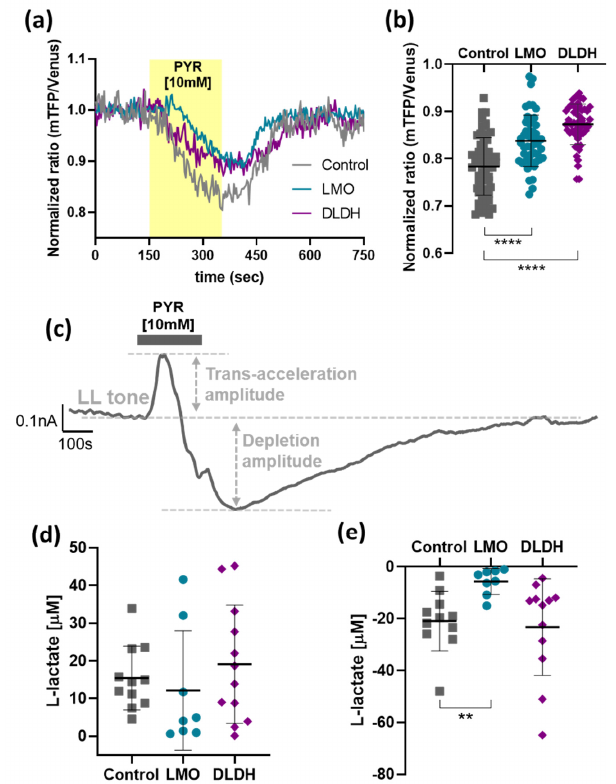
Figure 6. Effect of LMO and DLDH on the forced release of lactate. ( a ) Representative traces of La- conic FRET ratio following application of pyruvate [10 mM] in astrocytes expressing AVV-CMV- Laconic alone (Control) or in combination with AVV-sGFAP-LMO-IRES-tdTomato (LMO) or AVV- sGFAP-DLDH-IRES-tdTomato (DLDH). ( b ) Pooled data of the minimum value from Laconic FRET ratio following pyruvate application (Control, n = 62; LMO and DLDH, n = 52). **** p < 0.0001, one way ANOVA with Tukey multiple comparison test. ( c ) Representative trace of an amperometric recording during pyruvate [10 mM] application. ( d ) and ( e ) Pooled data for the trans-acceleration and depletion amplitude, respectively, following pyruvate [10 mM] application in organotypic brainstem slices transduced with AVV-PRSx8-EGFP alone (Control, n = 11) or in combination with either AVV-sGFAP-LMO-IRES-tdTomato (LMO, n = 8) or AVV-sGFAP-DLDH-IRES-tdTomato (DLDH, n = 12). ** p < 0.01, Kruskal–Wallis one-way ANOVA on ranks, followed by Dunn’s test.